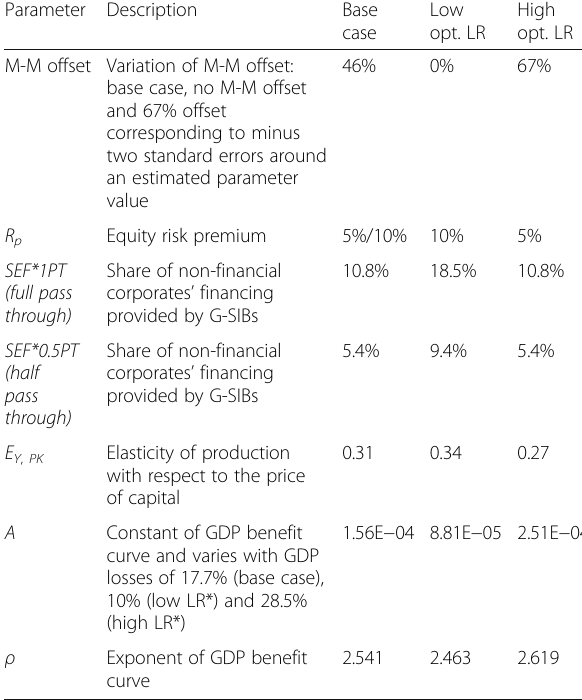
Table 14 Base case parameter values and